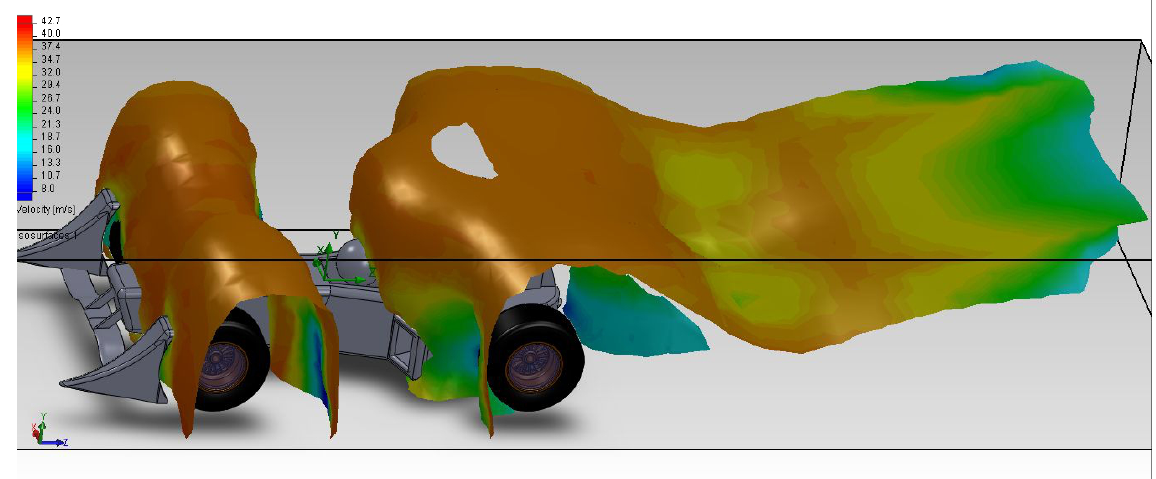
Figure 12. Spatial air flow velocity distribution on optimized